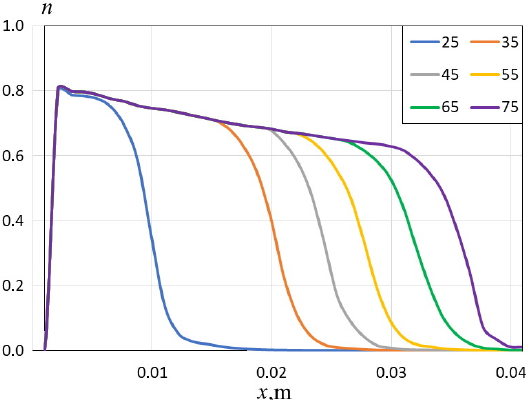
Figure 15. Vapor fraction n along the cylindrical nozzle at different temperatures (temperature is shown in °C) (from our CFD results). In general, all physical values in Equation (1) have some relationship with tempera- ture. The growth of vapor pressure p v and decrease of density ρ of the fluid will lead to a